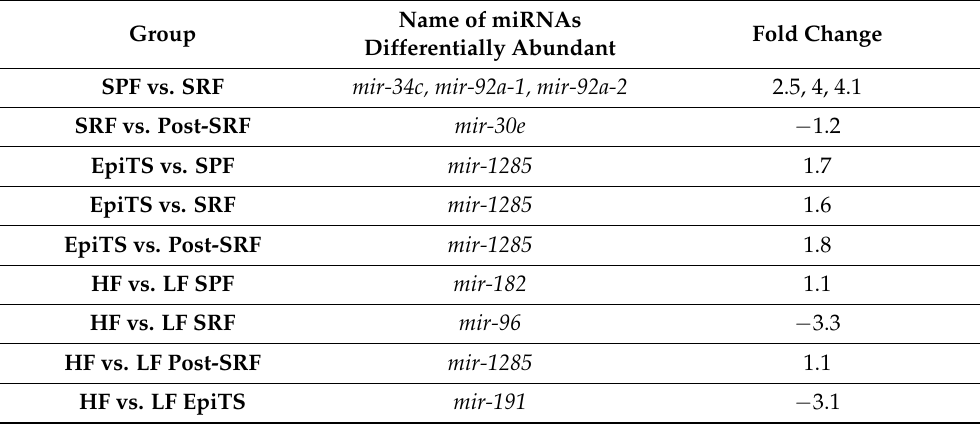
Figure 2. Chromosome location (left image) and miRNA precursor structure (right image) of all differentially expressed microRNAs (miRNAs) ( p -value < 0.05 and ≥ 1.0-Fold Change (FC) or ≤ − 1.0) presented in this study: mir-182 (A,a), mir-191 (B,b), mir-34c-1 (C,c), mir-96 (D,d), mir-92a (E,e), mir-30e (F,f), mir-1285 (G,g). The images were created in Rfam version 14.5 [37]. The black color in the miRNA structure represents a template model, while differences between the template and the sequences are highlighted in color, depending on whether it is a modification (green), an insertion (pink), or a reposition (blue). Structures were generated by R2DT using the d.5.e.P.waltl template provided by CRW [38], copyright © 2021 Rfam Team. Table 3. Differentially abundant microRNAs (miRNAs, p -value < 0.05) in spermatozoa collected from the three ejaculate fractions studied (SPF: sperm-peak fraction; SRF: sperm-rich fraction; and post- SRF) and from the functional epididymal terminal segment (EpiTS) among all boars or comparing high-and low fertility